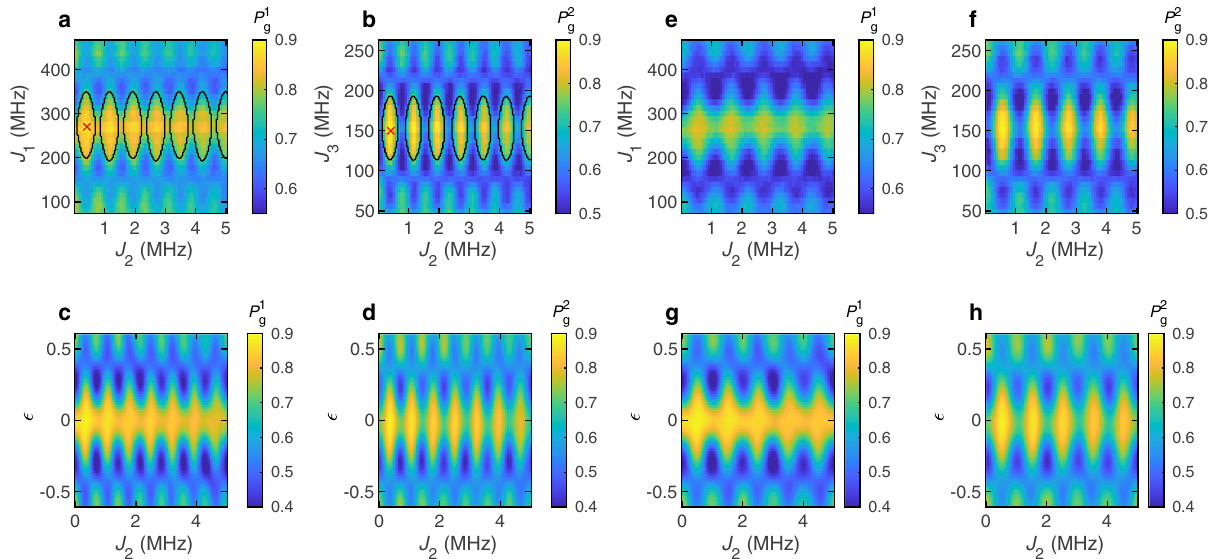
Fig. 2 Floquet-enhanced π rotations. a , b Measured ground-state return probabilities of ( a ) ST qubit 1 and ( b ) ST qubit 2, after four Floquet steps, with interaction time τ = 1.4 μ s. The ranges of J 1 and J 3 center around J π and J π . The values of J 1 and J 3 are swept simultaneously. In both fi gures, the red cross 1 3 marks the condition for the Floquet-enhanced π rotations. The black ovals are the semiclassical phase boundaries. c , d Simulated return probabilities of ( c ) ST qubit 1 and ( d ) ST qubit 2, corresponding to the data in ( a ) and ( b ), respectively. e , f Measured ground-state return probabilities of ( e ) ST qubit 1 and ( f ) ST qubit 2, after four Floquet steps, with interaction time τ = 1.0 μ s. J 1 and J 3 values are the same as in a and b . g , h Simulated return probabilities of ( g ) ST qubit 1 and ( h ) ST qubit 2, corresponding to the data in ( e ) and ( f ), respectively. The experimental data in ( a , b , e , f ) are averaged over 8192 realizations. In all fi gures, P k indicates the ground-state return probability for ST qubit k g